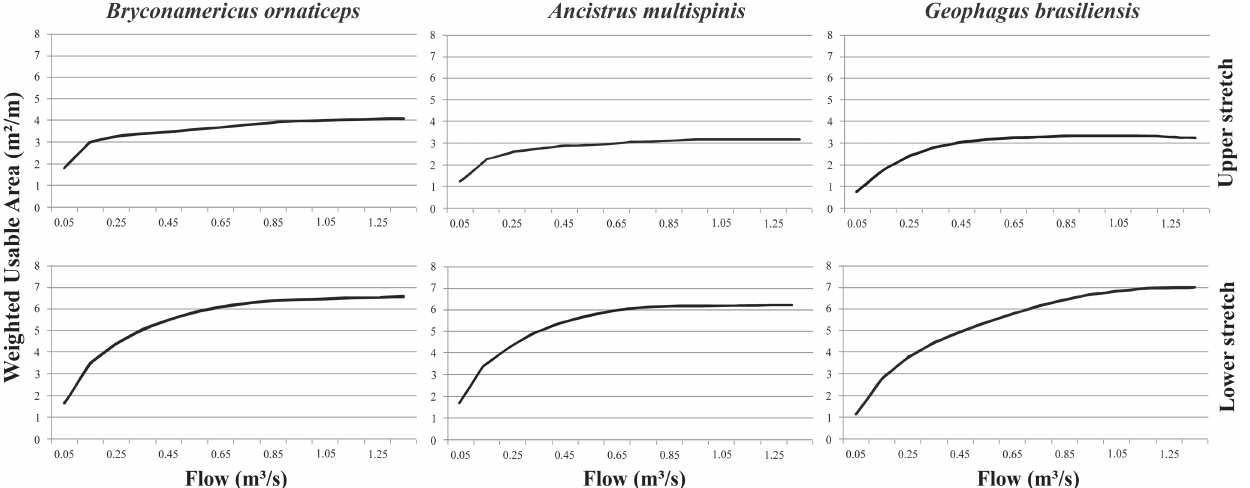
Fig. 6. Weighted usable area (WUA) in the upper and lower reach of the riacho São Pedro, for the three fish